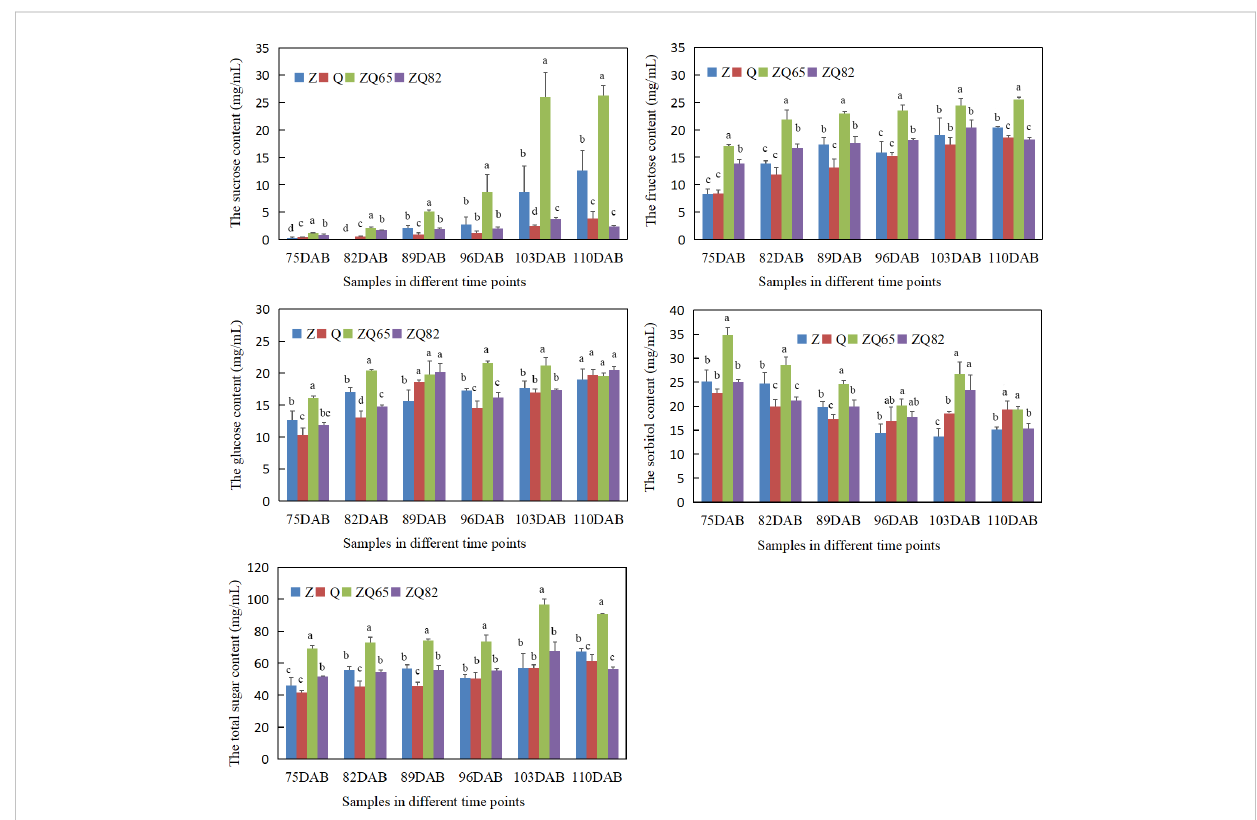
FIGURE 3 Sucrose, fructose, glucose, sorbitol, and total sugar contents in four cultivars during fruit ripening. Statistical analyses were performed at each time point using the analysis of variance (ANOVA) and Duncan tests, Different low case letters above columns indicate statistical differences at p ≤